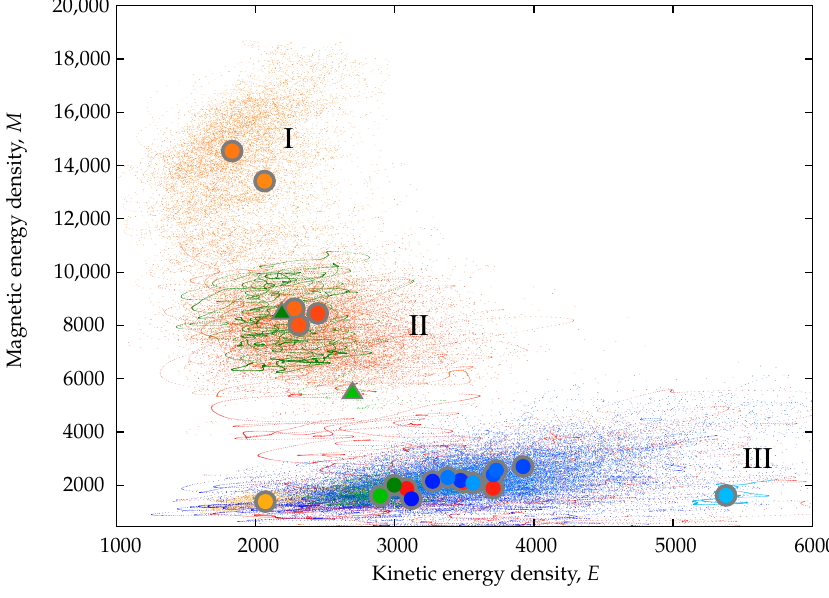
Figure 9. A “phase portrait” of magnetic vs. kinetic energy density values for dynamos with 10 4 , P = 0.75 and P m = 1.5. Dots are instantaneous values; large markers R = 3.8 R c , τ = 2 × × are time-averaged values. The aspect ratio η increases from darker to lighter colours (blue to orange). Blue dots and points represent dynamos that were started from FD initial conditions. Warm colours and greens represent simulations that were started from MD initial conditions. Green symbols and dots represent simulations that were started as from MD initial conditions at η = 0.6 and η = 0.7 and that were repeated starting from a higher magnetic energy and lower kinetic energy (triangles) relative to the original simulations (circles). (Colour